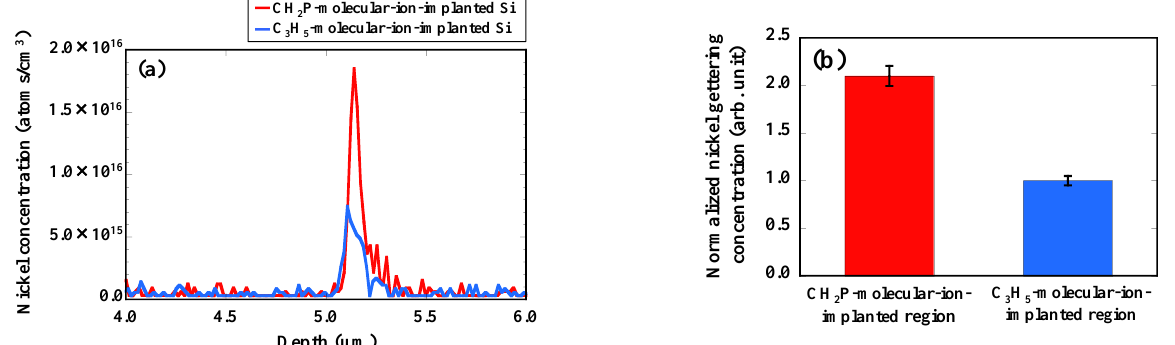
Figure 6. ( a ) SIMS depth profiles of concentration of gettered nickel impurities in CH 2 P- and C 3 H 5 - molecular-ion-implened regions of CMOS image sensors. ( b ) Normalized amount of nickel gettered in CH 2 P- and C 3 H 5 -molecular-ion-implaned regions after CMOS image sensor fabrication process.